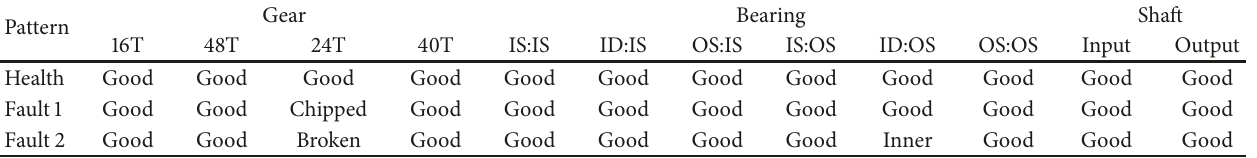
Table 1: Pattern description of the gearbox: IS=input shaft;:IS=input side; ID=idler shaft;:OS=output Side; OS=output shaft.